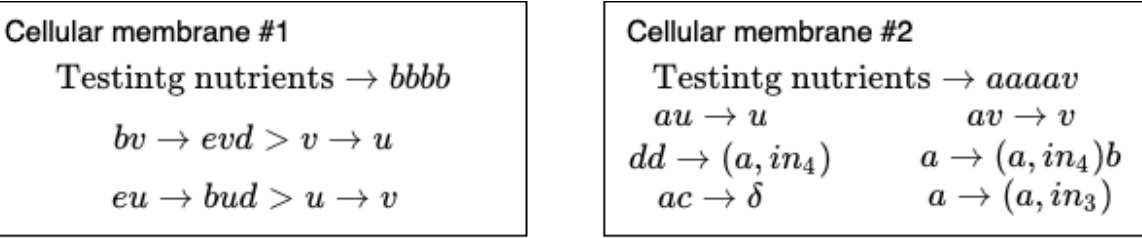
Figure 6. Two-membrane systems designed to multiply the number of b’s and